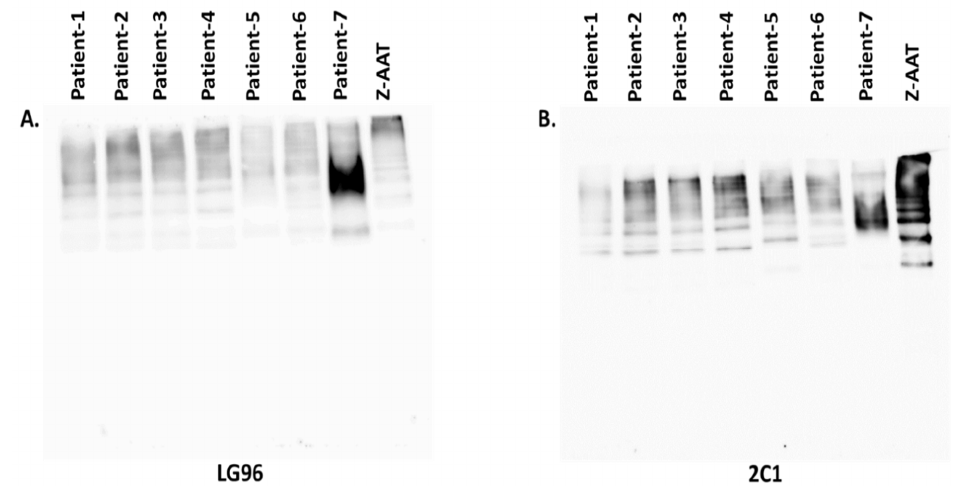
Figure 4. Z-AAT polymer analysis by Western blots using two different monoclonal antibodies. Equal amounts of plasma samples from seven ZZ-AATD individuals were electrophoretically separated using 7.5% native polyacrylamide gels followed by western blots. Purified polymeric Z-AAT isolated from pooled ZZ plasma samples was used as a positive control. The western blots were probed against mouse monoclonal anti-AAT polymer antibodies LG96 ( A ) and 2C1 ( B )(both diluted 1:700). The image demonstrates that both antibodies recognize the Z-AAT polymers, but the profiles of recognized polymers differ. This blot is the representative from n = 2 independent repeats. Biomolecules 2022 , 12 , x FOR PEER REVIEW